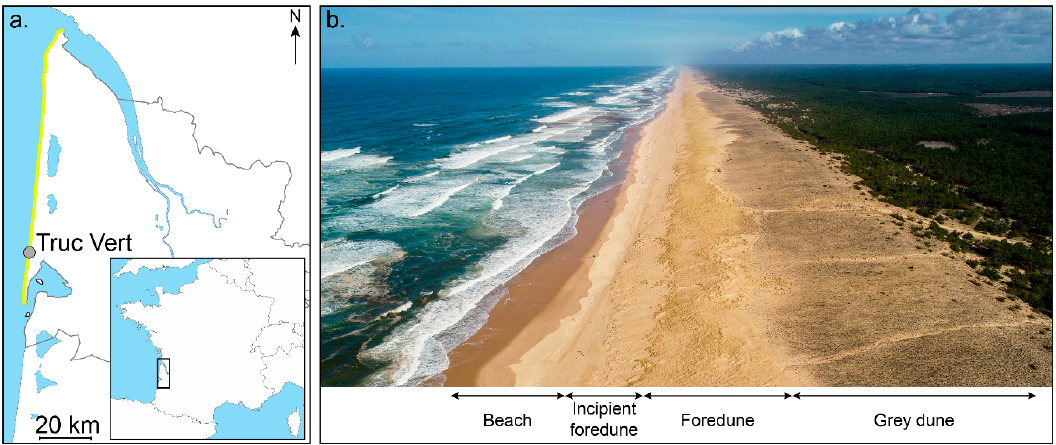
Figure 1. ( a ) Map of the Gironde coast (yellow line) in SW France with location of Truc Vert beach, ( b ) Truc Vert beach with a well-managed alongshore-uniform coastal dune (Ph. V. Marieu).